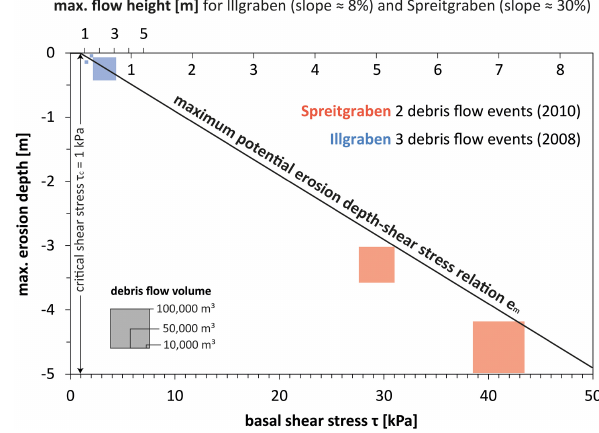
Figure 3. A linear relationship for maximum erosion depth as a function of basal shear stress forms the basis of the model. The size of the boxes is proportional to the estimated event volume at the Ill- graben (3 debris-flow events, Berger et al., 2010b) and Spreitgraben (2 events, Geotest, 2010). The upper axis indicates the flow height at the Illgraben (8% channel slope) with the numbers above the axis, and at the Spreitgraben (30% slope) with the flow depth val- ues placed below the axis; the corresponding shear stresses (Eq. 5) are plotted at the bottom of the